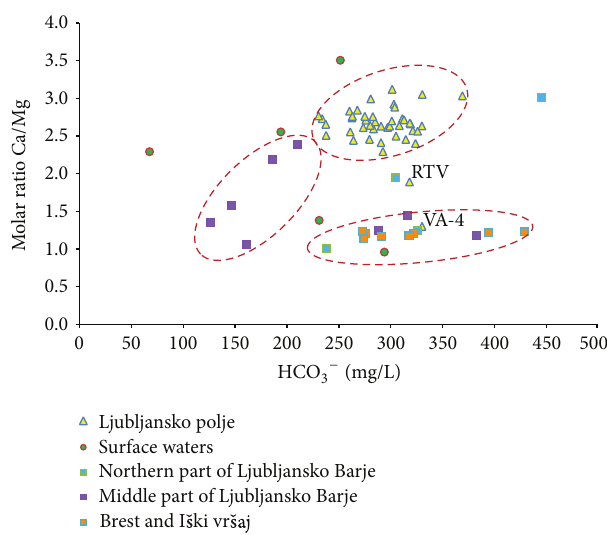
Figure 11: Relationship between HCO 3− and Ca/Mg molar ratio in groundwater of Ljubljansko polje and Ljubljansko Barje aquifers.